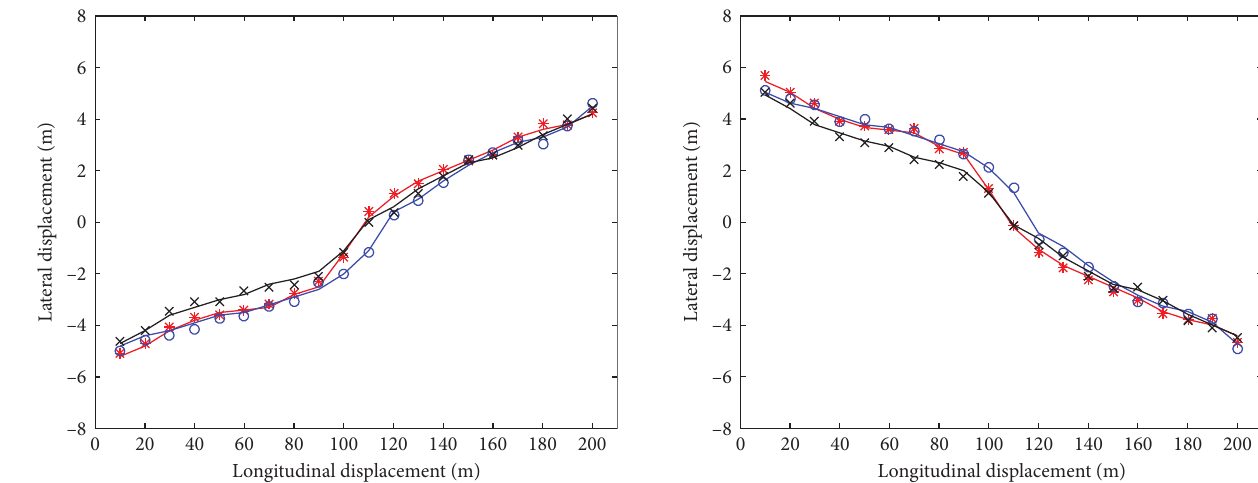
Figure 5: Actual test data and simulation data of left lane change. Figure 6: Actual test data and simulation data of right lane